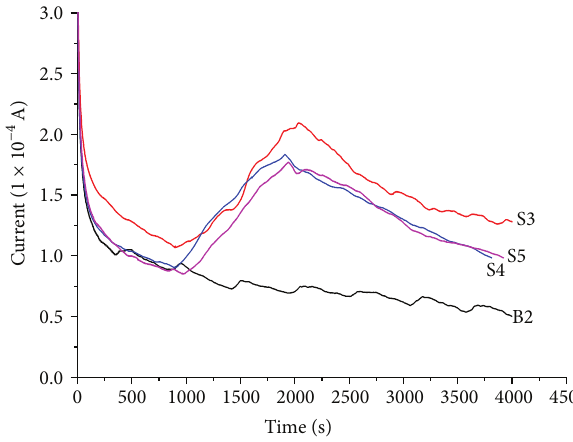
Figure 3: Electrons transfer mechanism of the spirulina biosolar cell.